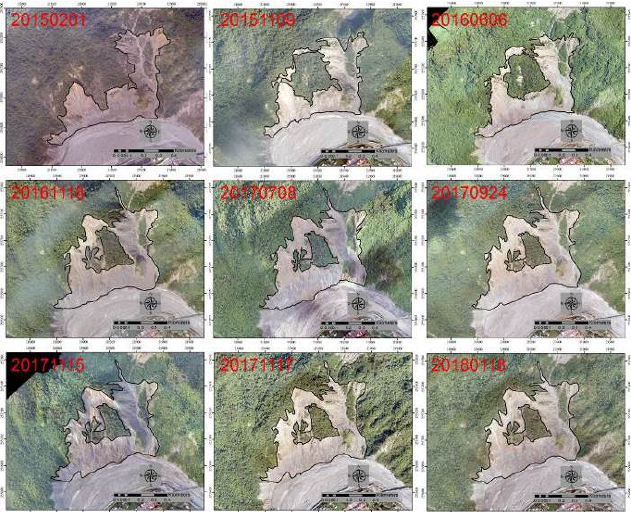
Figure 3. Orthomosaoic images acquired in different